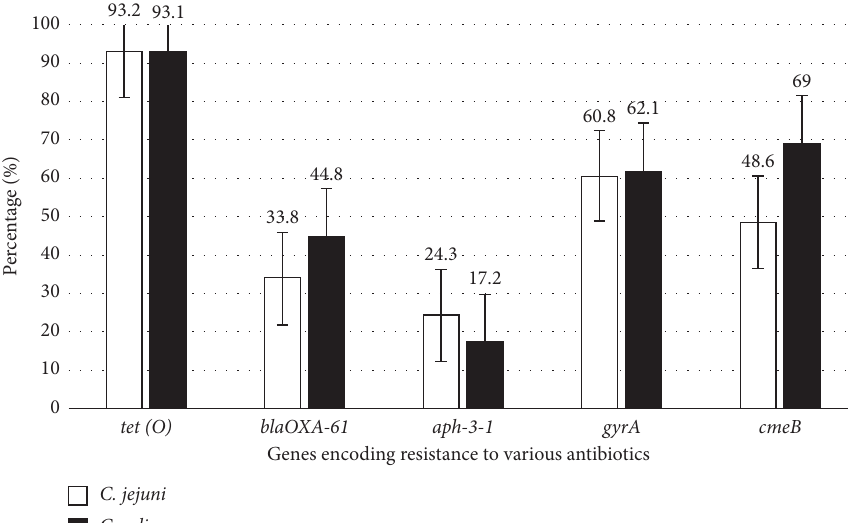
Figure 4: Percentage of Campylobacter isolates that harbour antimicrobial resistance gene. Results shown are the percentage prevalence ± standard